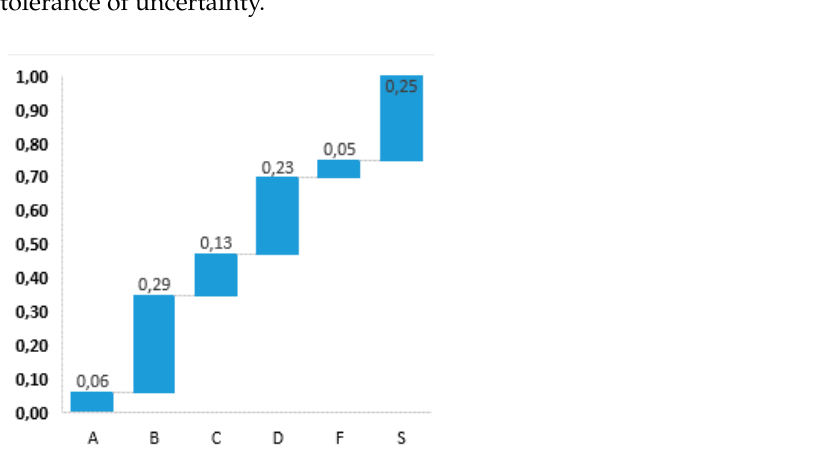
Figure 13. Makeup of the PRG zones extracted from the PTM of the Umbria